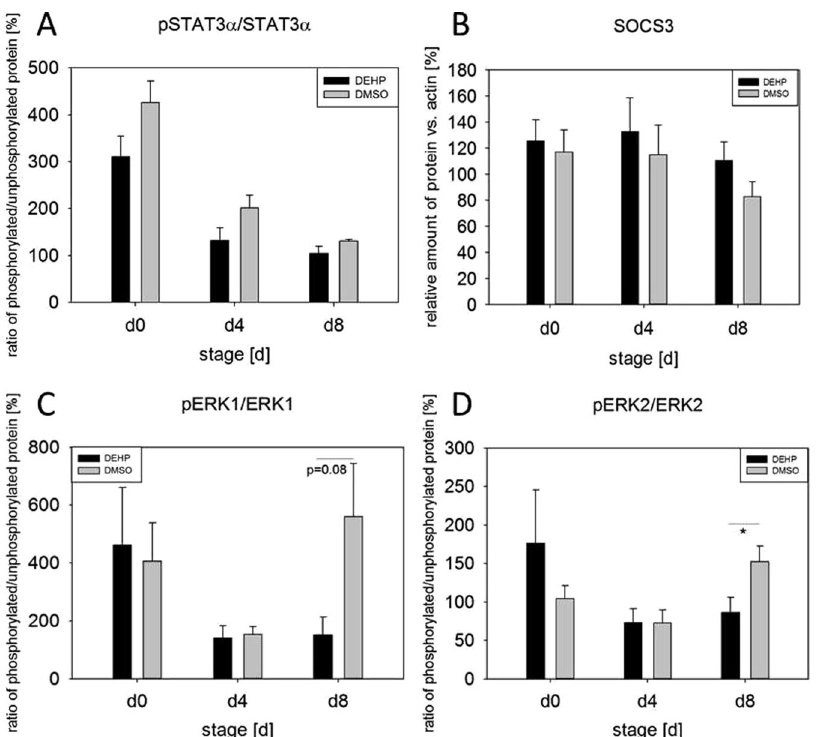
Figure 6. Impact of DEHP on JAK/STAT and ERK1/2 pathway: SGBS cells were exposed to DEHP from d0-d4 and subsequently differentiated into adipocytes. For western blot analysis of pSTAT3 α /STAT3 α ( A ), SOCS3 ( B ), pERK1/ERK1 ( C ), pERK2/ERK2 ( D ) samples were taken at d0, d4 and d8 of differentiation. Statistics: Student’s t-test (Wilcoxon rank-sum test); N ≥ 4, n = 1 (4 pooled wells